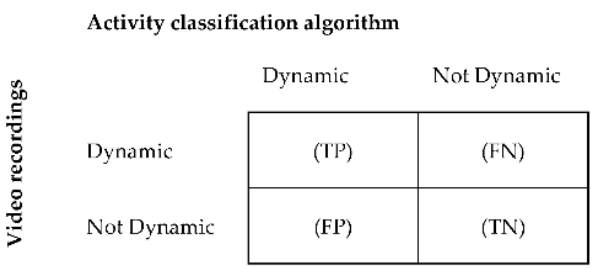
Figure 3. Binary confusion matrix for the classification of dynamic activities per patient. True positive (TP) = number of windows correctly classified by the algorithm as dynamic; false positive (FP) = number of windows incorrectly classified as dynamic; true negative (TN) = number of windows correctly classified as not dynamic, and false negative (FN) = number of windows incorrectly classified as not dynamic.